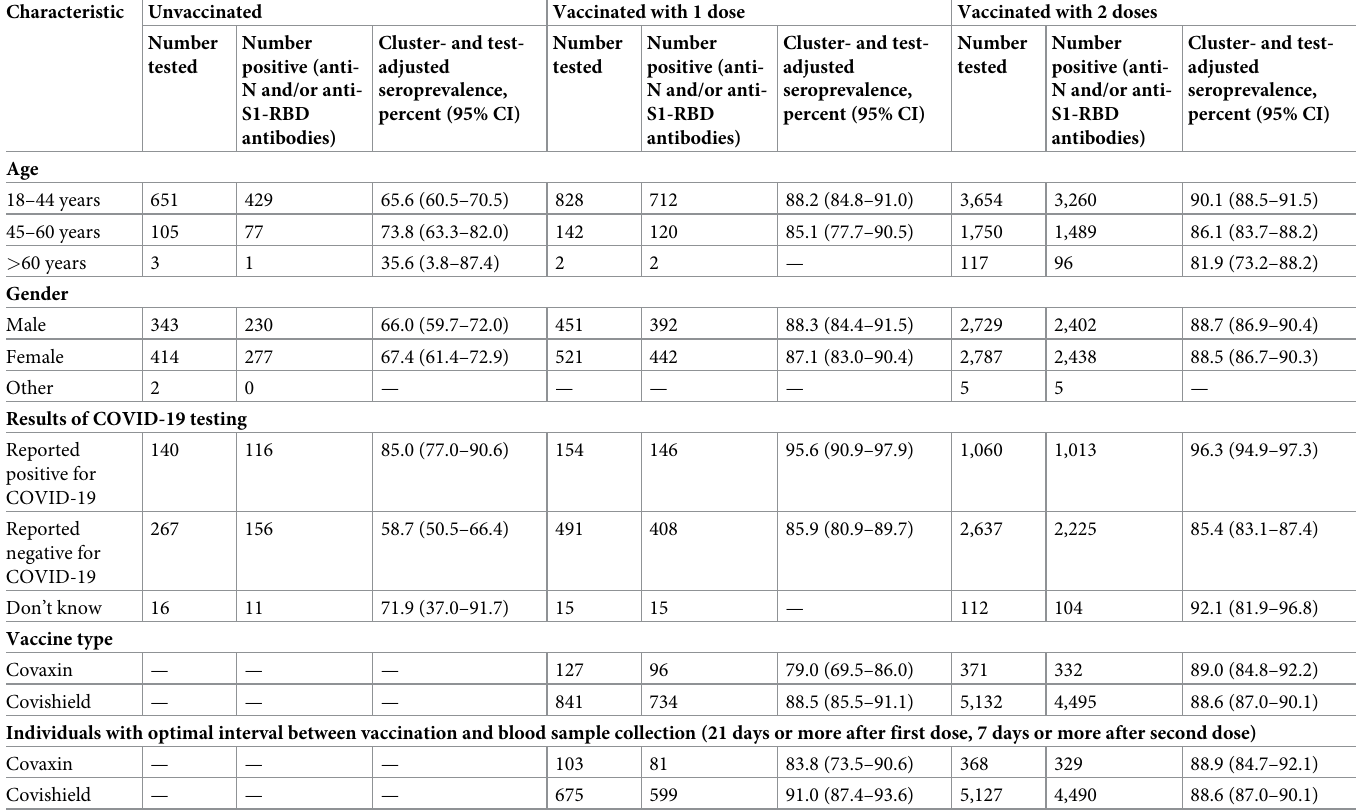
Table 5. Seroprevalence of IgG antibodies against SARS-CoV-2 among healthcare workers by vaccination status, June–July